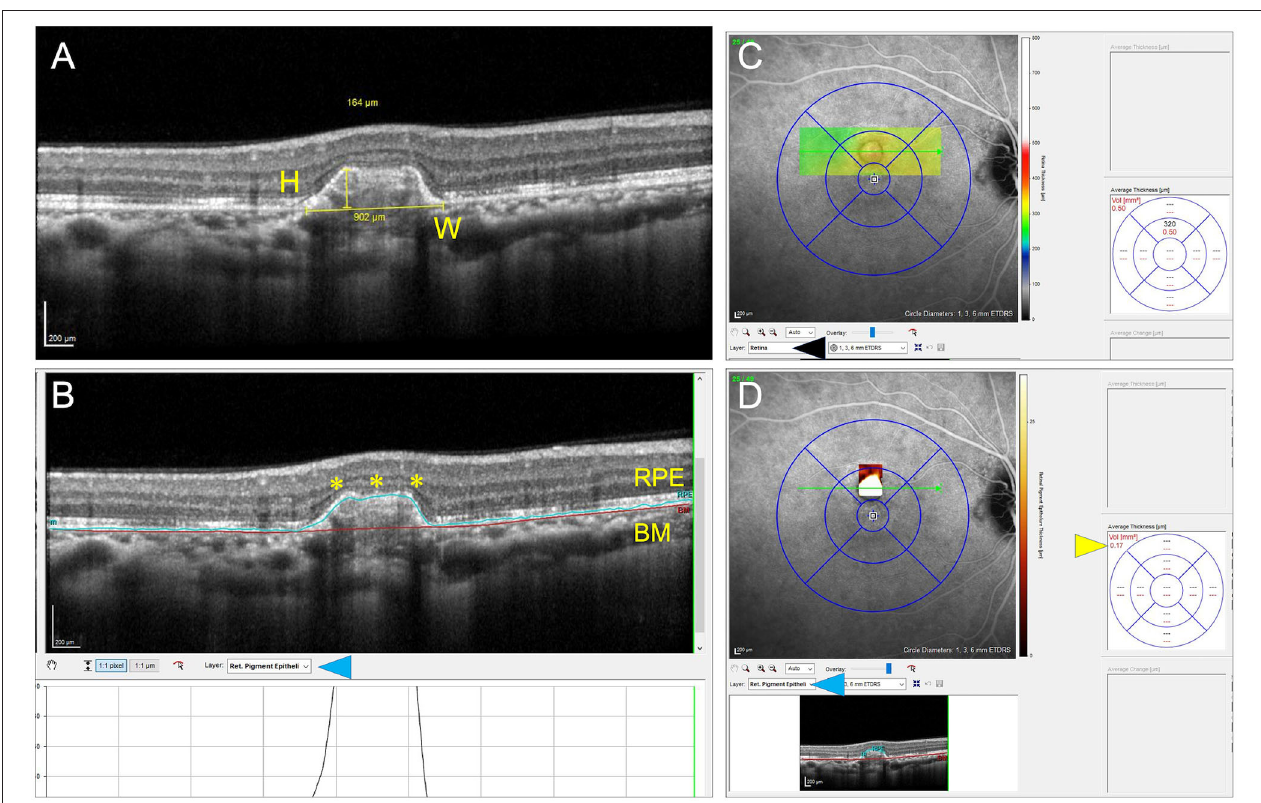
FIGURE 1 | This figure explains the process of measuring the quantitative metrics of the lesions of punctate inner choroidopathy (PIC). The height (H) and width (W) measurements of the inflammatory PIC lesion are shown in (A) . (B) Shows the measurement of the volume of the PIC lesion after performing manual segmentation of the retinal pigment epithelium (RPE) line and correcting the Bruch’s membrane (BM) line. The corrected RPE line is highlighted by yellow asterisks. The layer segmentation selection is shown by a blue arrowhead. (C,D) Show the technique of obtaining the volume measurements. By default, the software shows the volume of the entire retinal scan because the layer selection is “retina” (black arrowhead). When the RPE layer is selected (blue arrowhead), the volume of the RPE lesion is obtained (yellow arrowhead) (D)